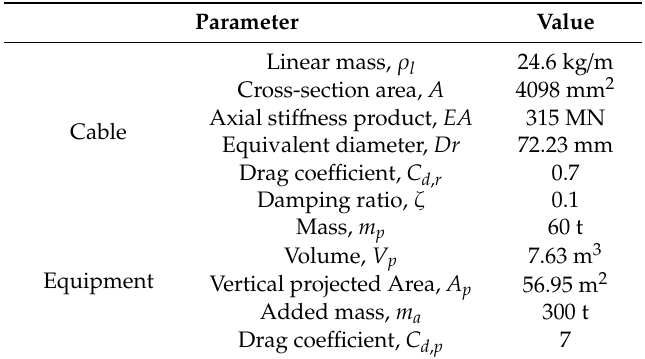
Table 1. System parameters for the model validation and analysis.